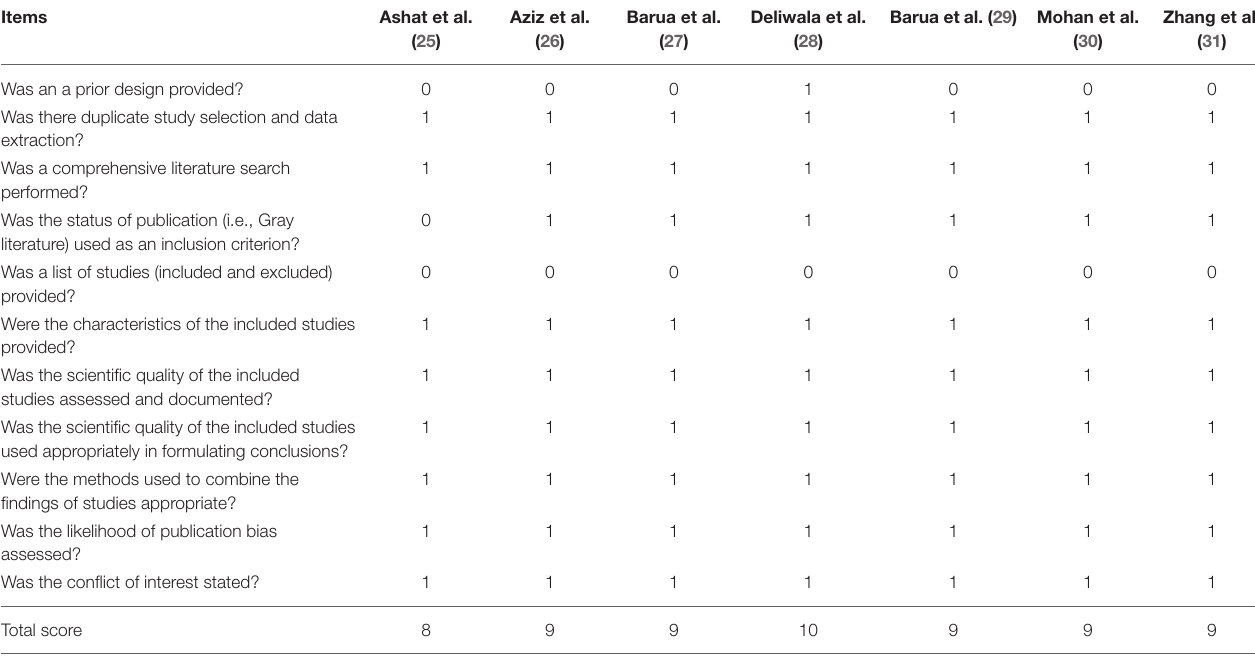
TABLE 5 | AMSTAR criteria for each meta-analysis.